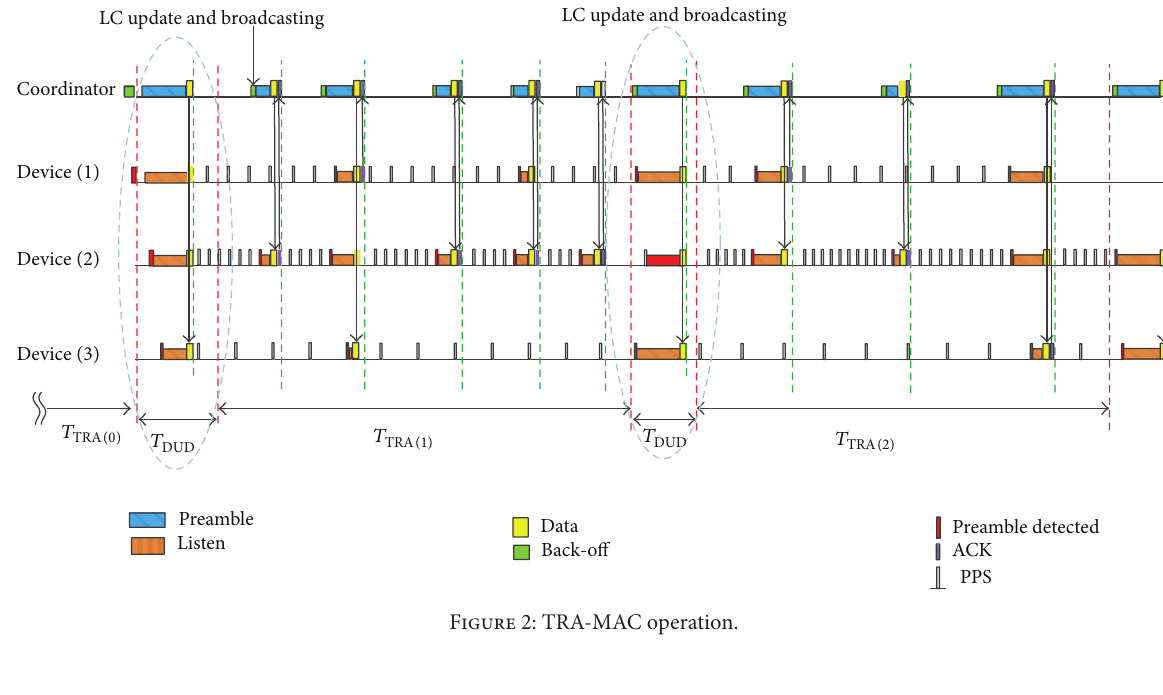
Figure 2: TRA-MAC operation.